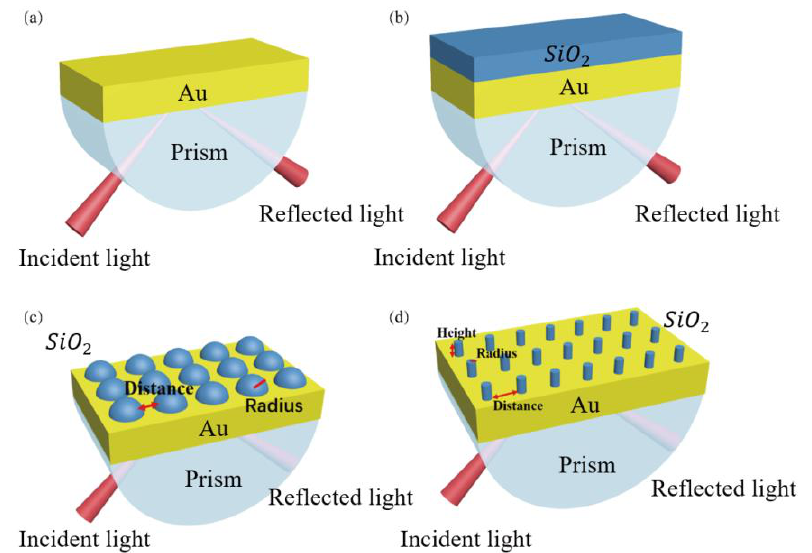
Figure 1. Schematic diagram of various structures of SPR sensors ( a ) Au film, ( b ) Au/SiO 2 thin film, ( c ) Au/SiO 2 nanospheres and ( d ) Au/SiO 2